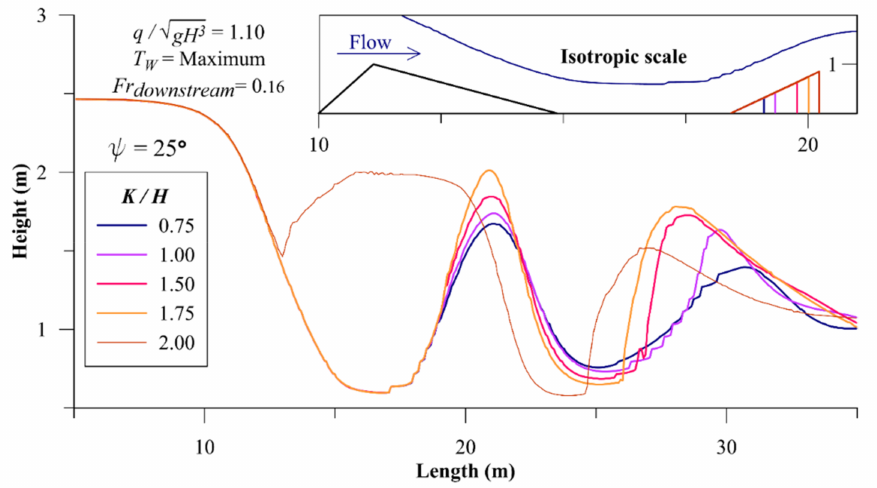
Figure 9. Effect of kicker length on wave